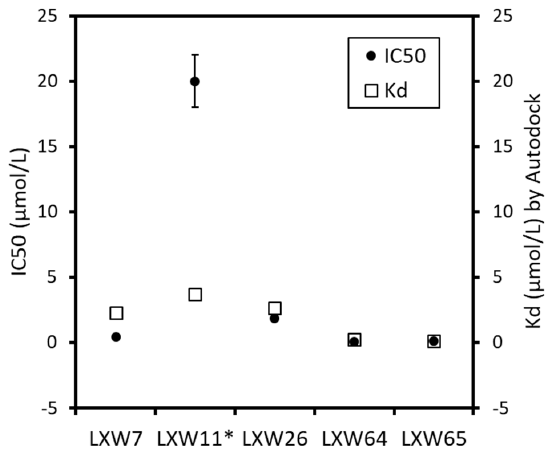
Figure 5. Comparison between the determined IC 50 and Autodock-calculated Kd of representative LXW analogs.